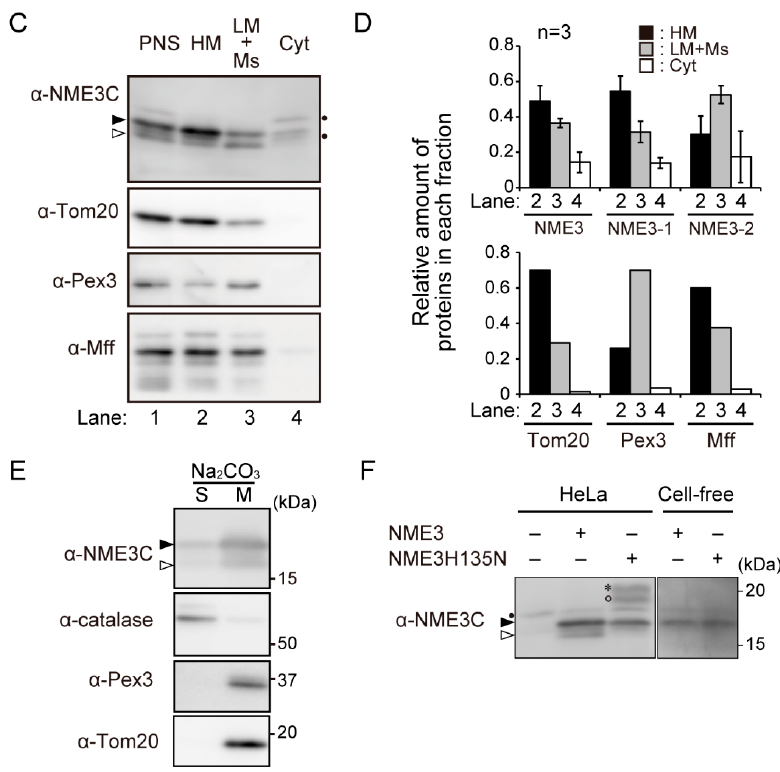
Figure 8. NDP kinase activity of NME3 is essential for the division of peroxisomes. ( A ) ectopic expression of NME3 and its mutant NME3H135N in HeLa cells was verified by immunoblotting of respective cell lysates with antibodies to NME3 and NME3C. NME3-HA 2 was likewise expressed and assessed with anti-HA antibody. Two bands, NME3-1, NME3-2, and HA 2 -tagged ones, respectively, marked by solid and open arrowheads were detected (lanes 2 and 3); three bands, NME3H135N, NME3H135N-a, and NME3H135N-b were marked by solid arrowhead, asterisk, and open circle, respectively. β -actin, a loading control. Dots indicate non-specific bands. ( B ) peroxisome morphology was verified by expressing NME3H135N in HeLa cells. Cell staining was performed as in Figure 6. Scale bar, 10 µm. Higher magnification image of the boxed regions was shown (Inset). Scale bar, 5 µm. ( C ) distribution of NME3 in heavy mitochondrial (HM) and post-HM membrane fractions containing light mitochondria (LM) and microsome (Ms) fractions. PNS fractions prepared from HeLa cells (lane 2 in ( A )) were fractionated as described in Materials and Methods and assessed for distribution of NME3 and marker proteins for mitochondria and peroxisomes with antibodies indicated on the left. Two bands indicated by solid and open arrowheads are as in ( A ). Dots, non-specific bands. ( D ) subcellular distribution of NME3 and marker proteins was represented in each fraction by taking as 1 total amount of respective proteins detected in lanes 2–4 ( n = 3). Solid, gray, and open bars indicate the levels in HM, LM plus Ms, and cytosol fractions, respectively. The values were represented as means ± SD of three independent experiments (upper panel) and a single experiment (lower panel), respectively. NME3 was mostly recovered in both HM (solid bar) and post-HM fractions (gray bar), where NME3-2 (open arrowhead in ( C )) was mainly recovered in the post-HM fraction. Note that NME3 was detected in a manner of a dual distribution in mitochondria and peroxisome fractions, similar to dually localized Mff. ( E ) organelle fraction (100,000× g pellet fraction of PNS) from HeLa cells expressing a higher level of NME3 was treated with 0.1 M Na 2 CO 3 and separated into soluble (S) and membrane (M) fractions. Equal aliquots of respective fractions were analyzed by immunoblotting with the indicated antibodies. Solid and open arrowheads are as in ( C ). ( F ) cell lysates prepared from HeLa cells expressing the NME3 variants and cell-free translated NME3 and the mutant NME3H135N were analyzed in the same SDS-PAGE gel and detected with NME3C antibody. Solid and open arrowheads, asterisk, open circle, and a dot are as in ( A ).